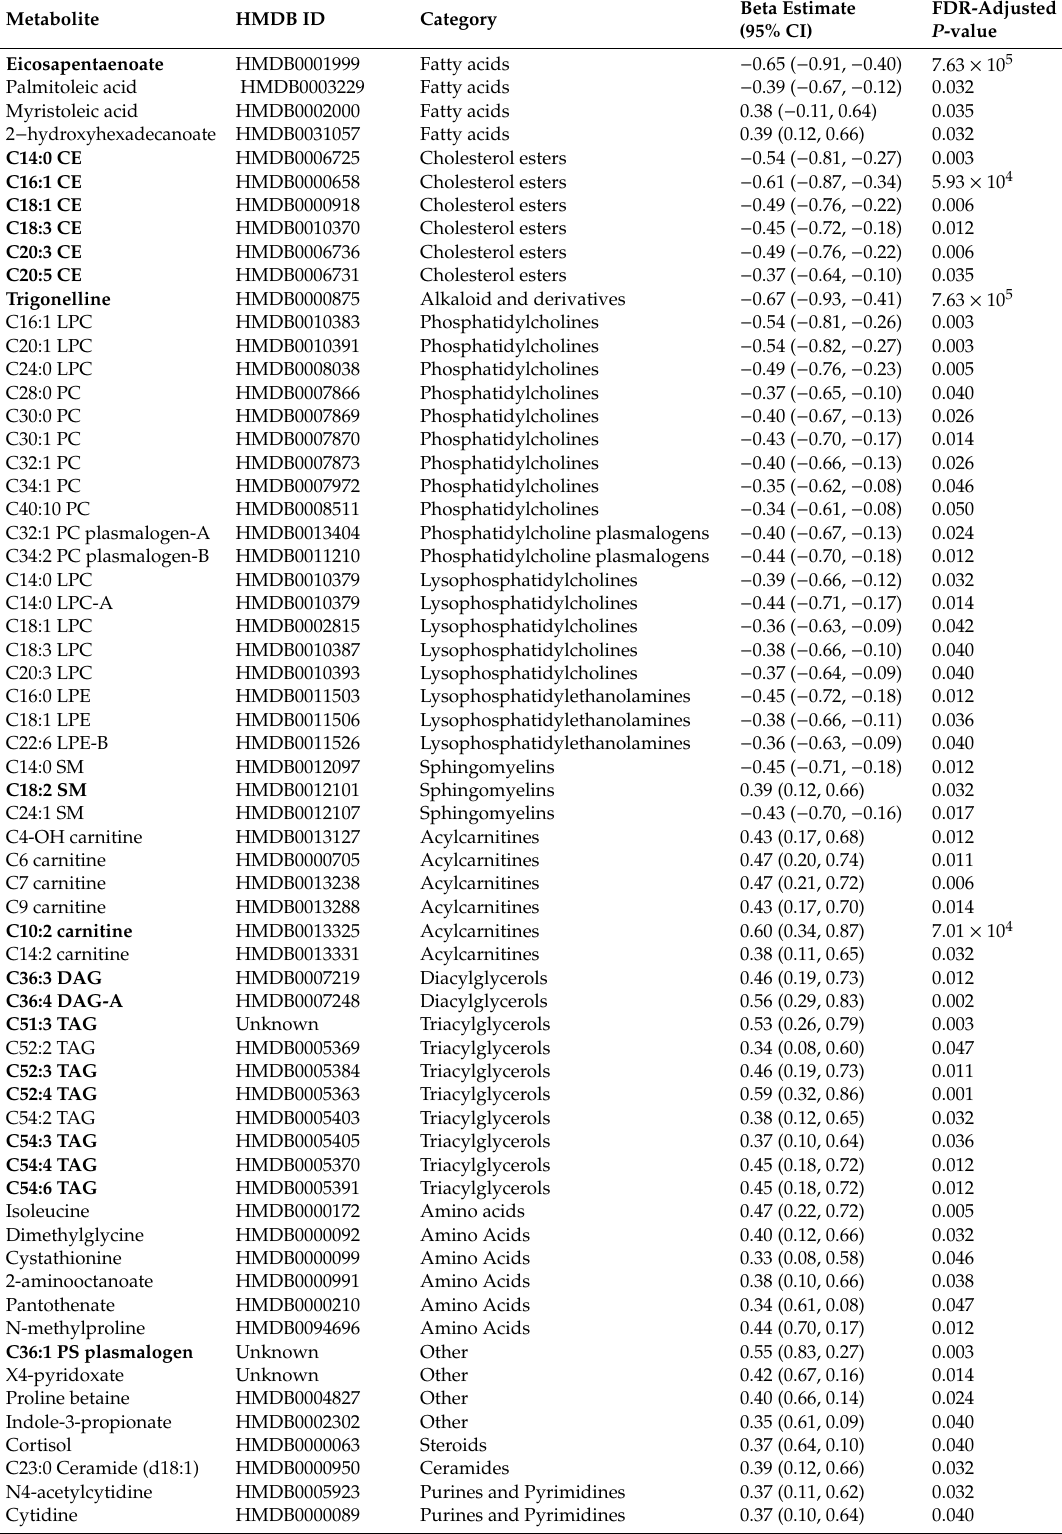
Table 6. Metabolite discovery among overweight or obese women ( n = 1289) 1,2,3